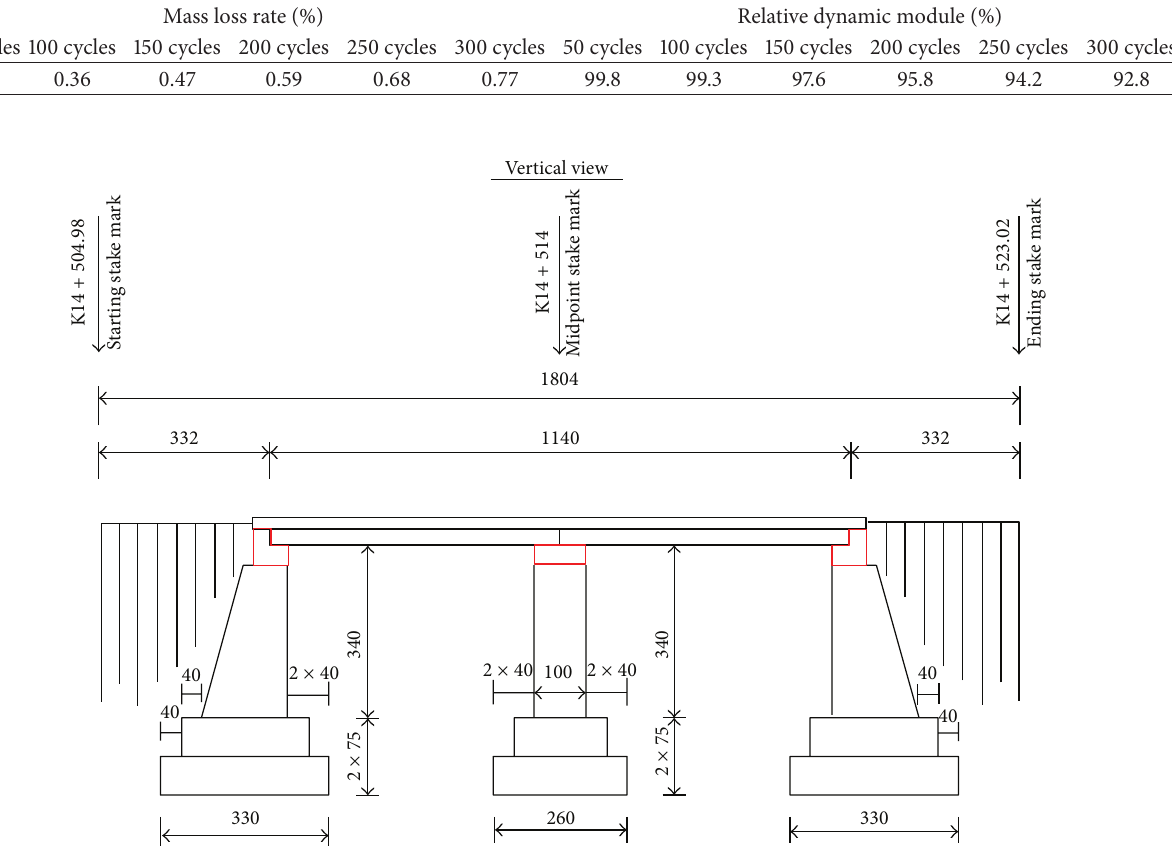
Table 4: Frost resisting durability of RPC200.